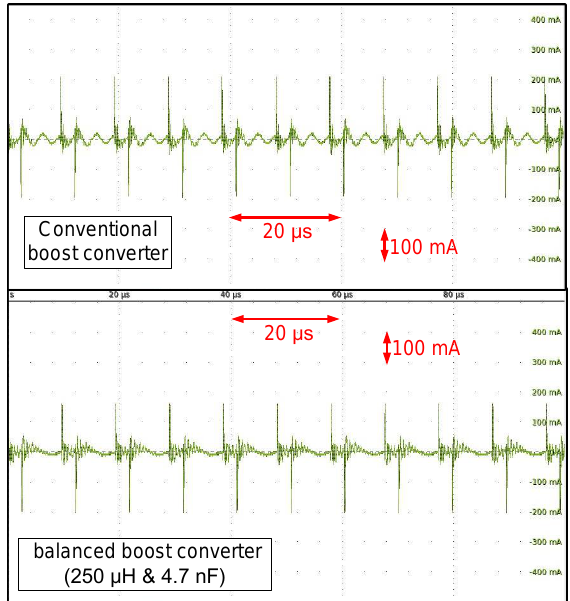
Figure 17. Experimental CM current waveforms comparison between CBC and optimized impedance balancing boost converter (250 μH and 4.7 nF).